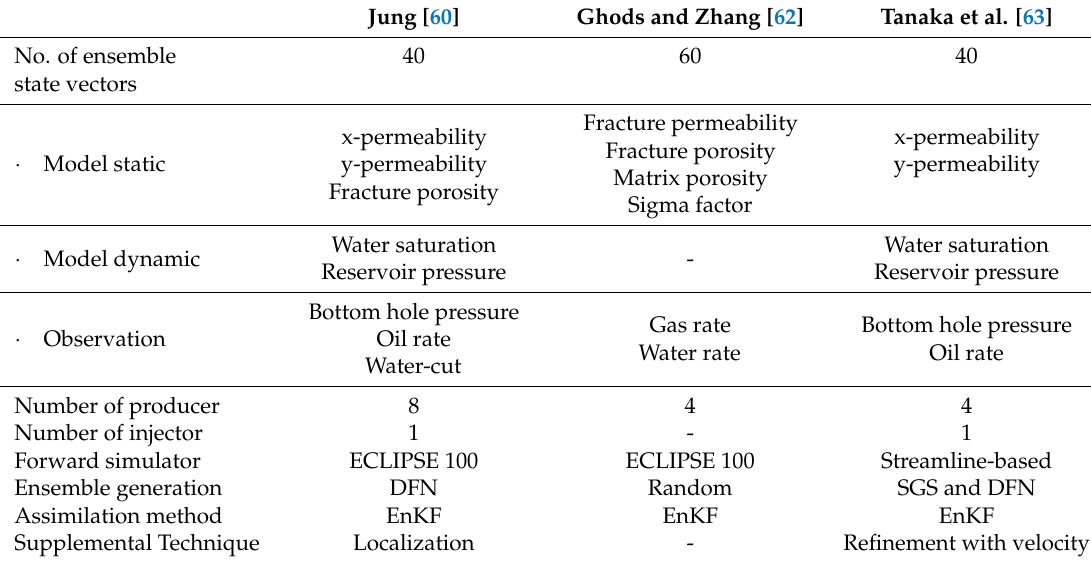
Table 2. Applications of ensemble based history matching for naturally fractured